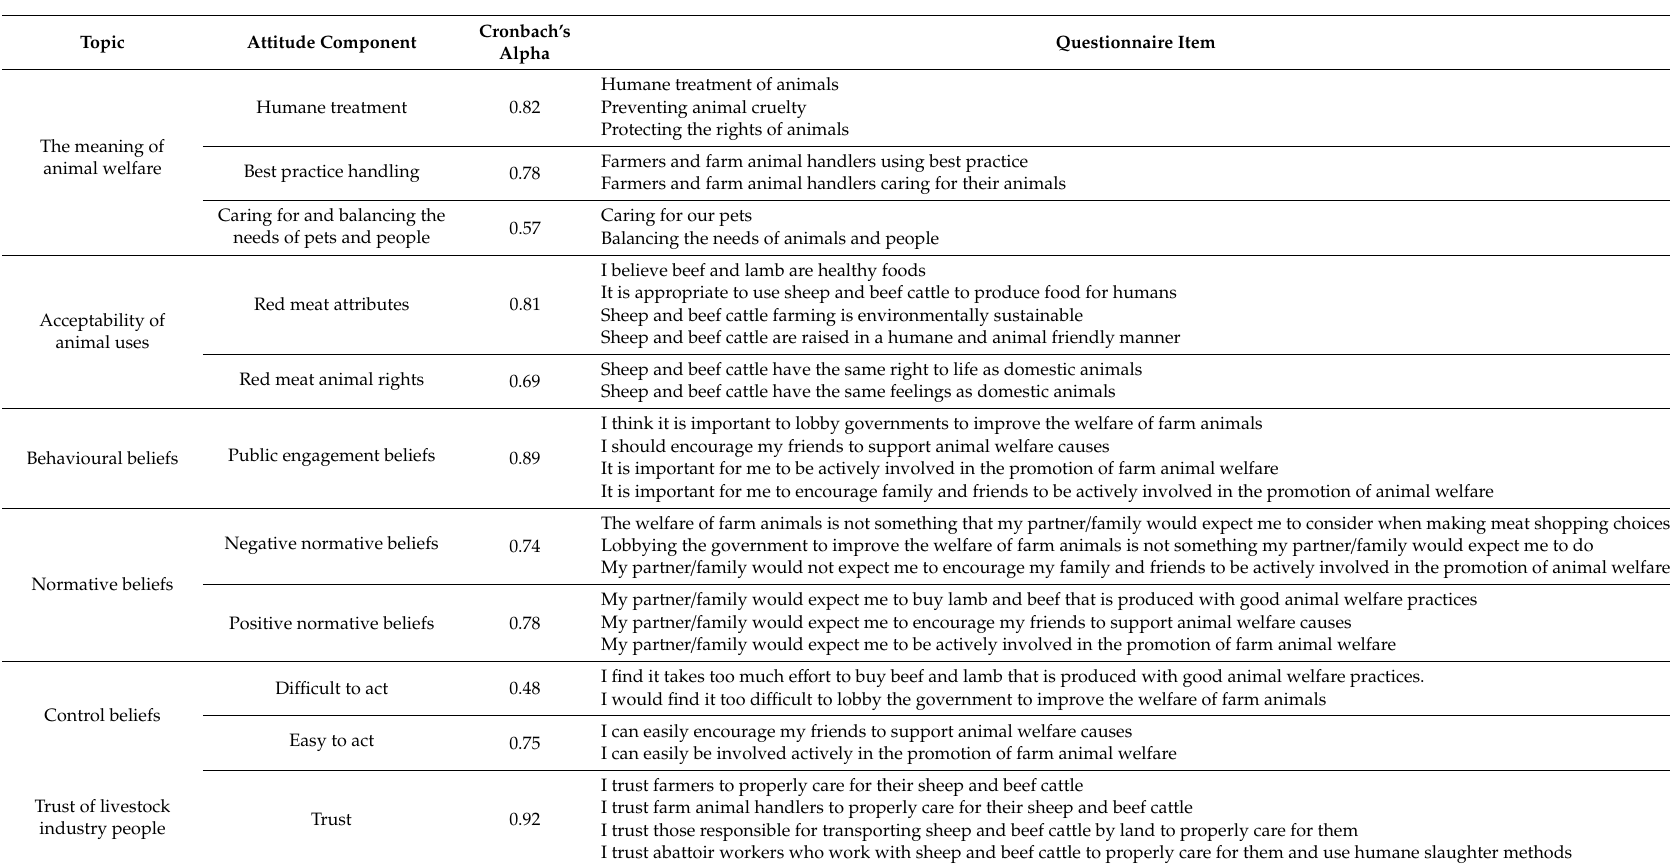
Table 4. Components from the questionnaire grouped into composite scores, a high score indicates positive attitude or strong agreement to the statements (questionnaire items). Cronbach’s Alpha was calculated using the full